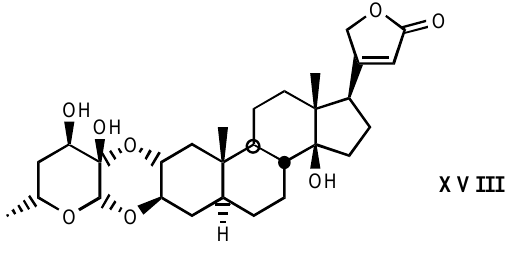
Figure 16. Structure of gomphoside XVIII .